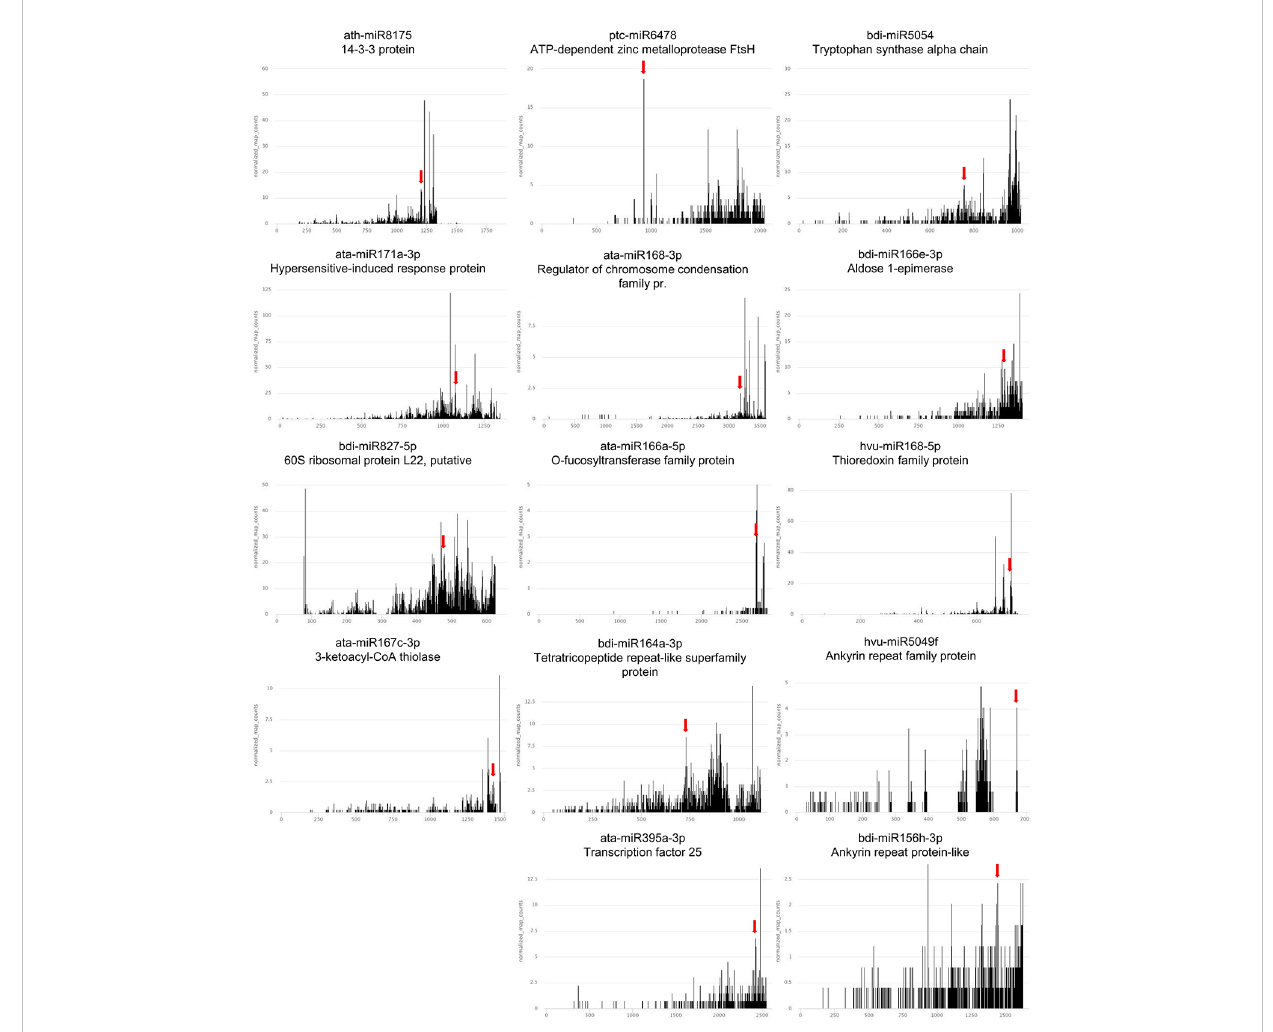
FIGURE 4 T-plots of the novel mRNA targets whose expression exhibits reversed correlation with cognate miRNA in drought and/or rehydration. The miRNA- driven cleavage site is marked by the red